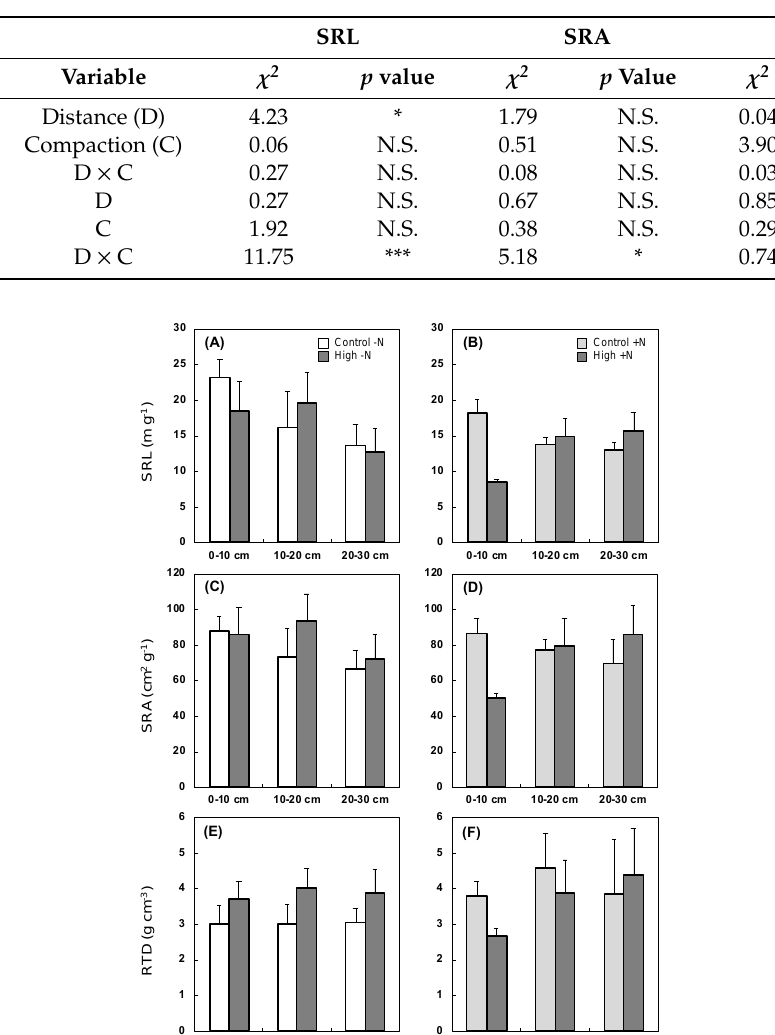
Figure 3. Mean value ± SE in specific root length (SRL), specific root area (SRA), and root tissue density (RTD) ( n = 5). The responses were showed without N loading ( A , C , E ) and with N loading ( B , D , F ). White and light gray: no compaction; dark gray: high compaction.